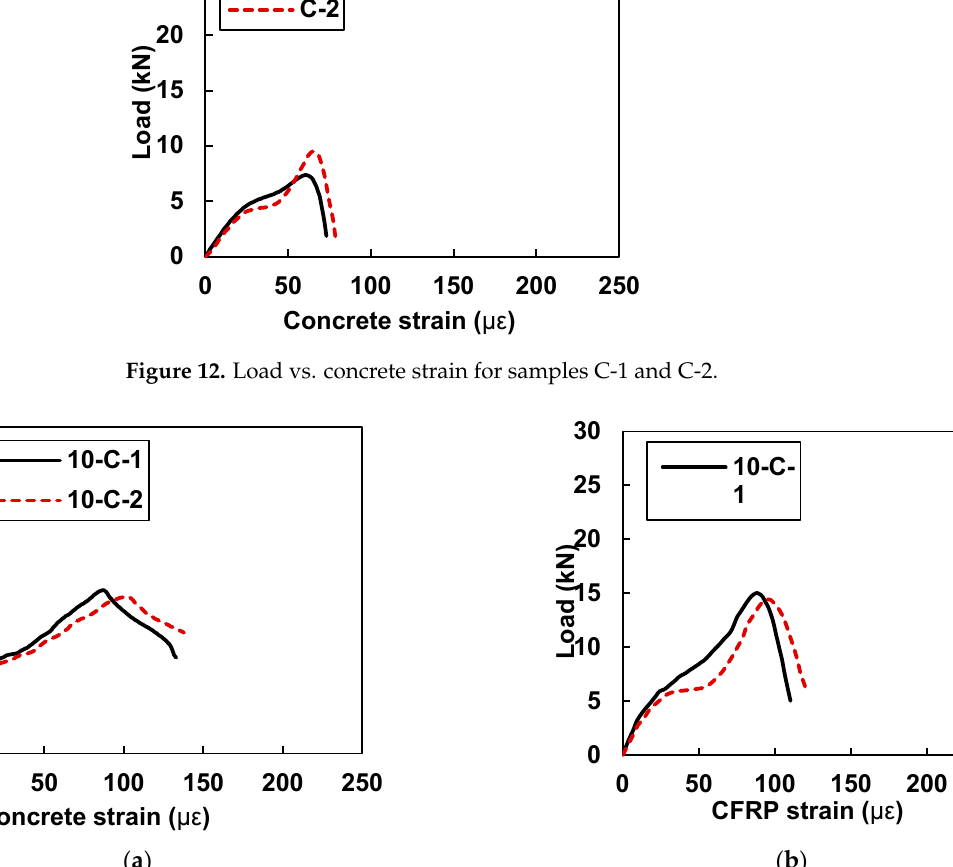
Figure 13. Load vs. strain curves for specimens with 10 mm CFRP strips (10-C-1 and 10-C-2): ( a ) strain in concrete and ( b ) concrete strain in CFRP.